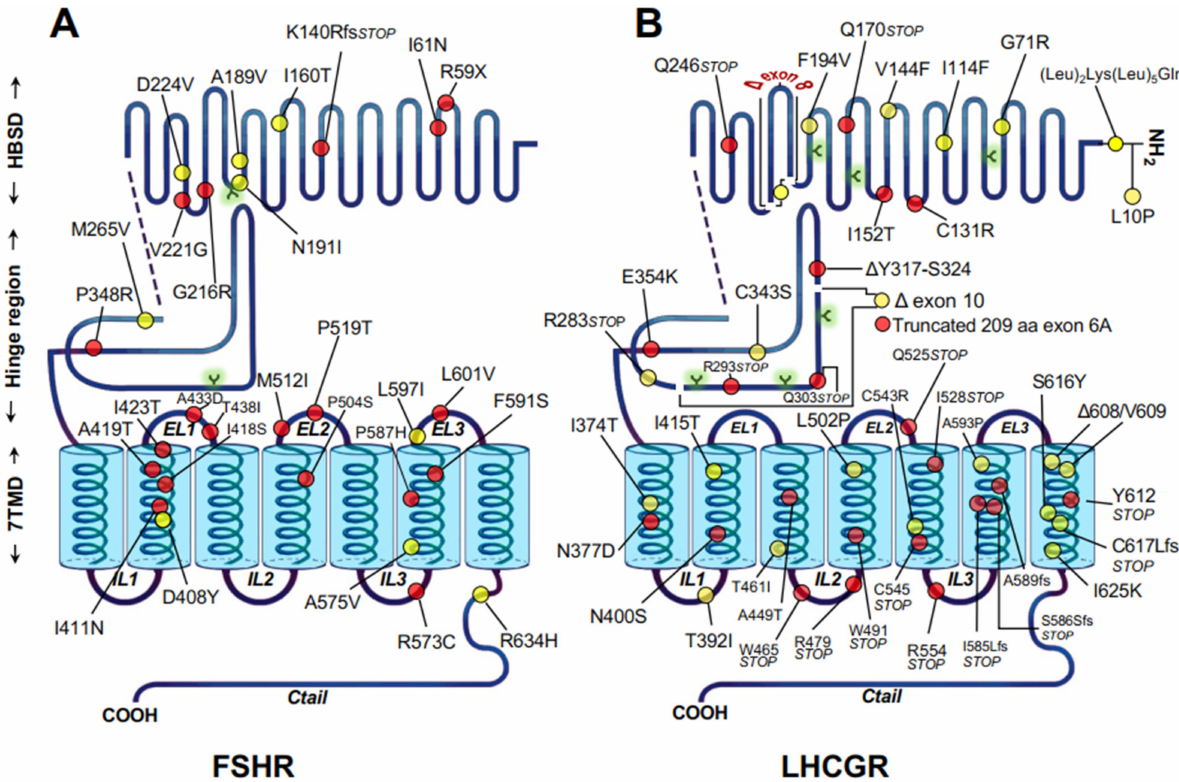
Figure 4. Schematic representation of the human gonadotrop í n receptors showing the location of the inactivating mutations described to date (red and yellow circles). Mutations indicated by the yellow circles lead to misfolding and trafficking defective receptors with reduced or absent cell surface plasma membrane expression. Arbor-like structures (shaded in light green circles) represent potential glycosylation sites. ( A ) FSHR; ( B )